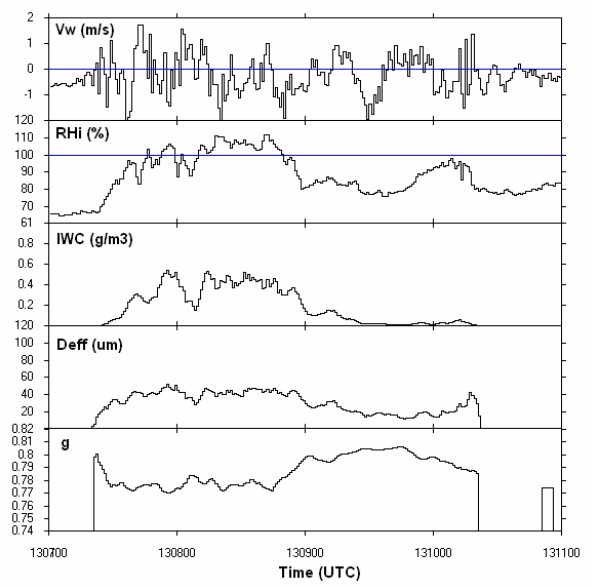
Fig. 11. Time-series of parameters measured in the overshooting cell (13:07–13:10UT): Vw : wind component, RHi: Relative hu- midity over ice, IWC: ice water content, Deff: effective diameter and g : asymmetry